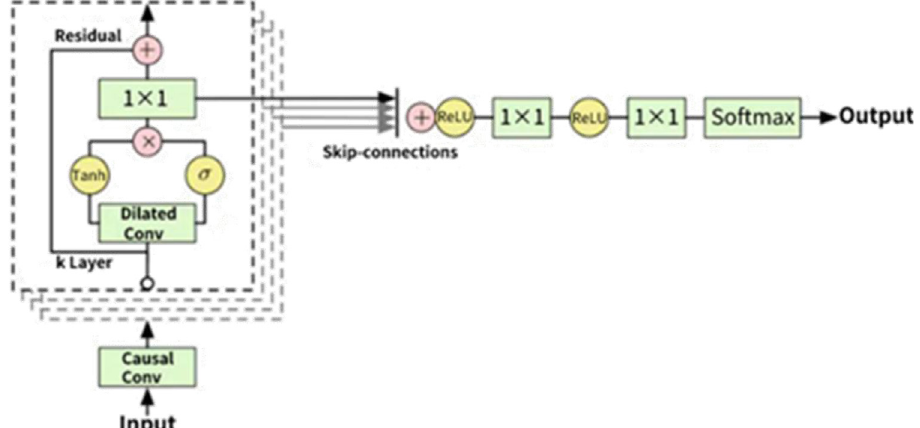
Fig. 6. Overview of the WaveNet entire architecture. A residual module in the model is shown in the dotted line. Multiple such modules will be stacked together in the network. K is the layer index. The nodes of each layer in the hidden layer will add the original value and the value of the activation function and pass it to the next layer. The 1 (cid:3) 1 convolution kernel is used to reduce the number of channels. Then the results of the over activated function of each hidden layer are added to do a series of operations and transmitted to the output layer. The output layer uses softmax to calculate the probability of each sampling point.